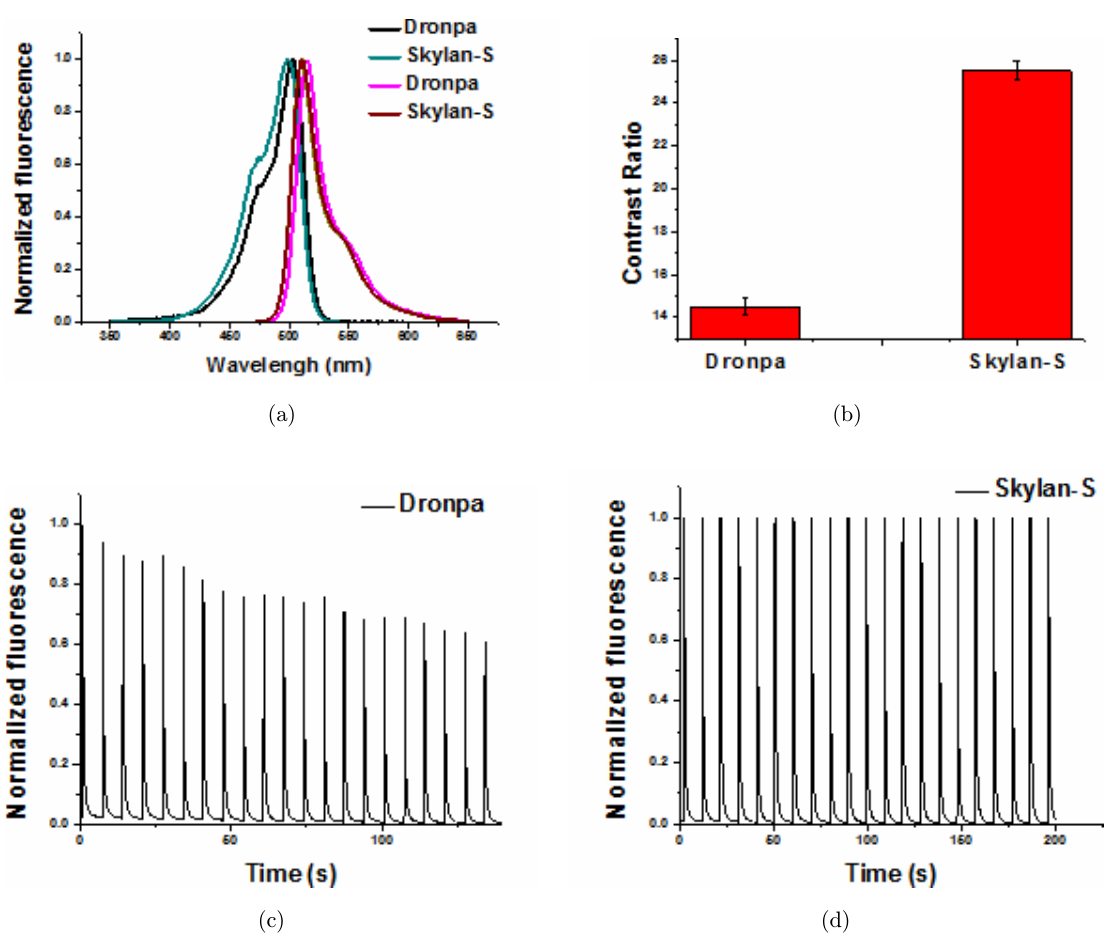
Fig. 2. (a) Excitation and emission spectra (measured at the excitation maximum). The excitation and °uorescence emission spectral pro¯les of Skylan-S and Dronpa were displayed. (b) Contrast ratios of Dronpa and Skylan-S. (c, d) Photoswitching kinetics of Dronpa and Skylan-S, respectively, measured in E.coli . E.coli cells expressing Dronpa and Skylan-S were continuously excited with 488 nm illumination (0.24 mW), and pulsed 0.01 s bursts of illumination with 405 nm light at a laser power of 0.2 mW were used to photoactivate the FPs. This ¯gure is from Ref.